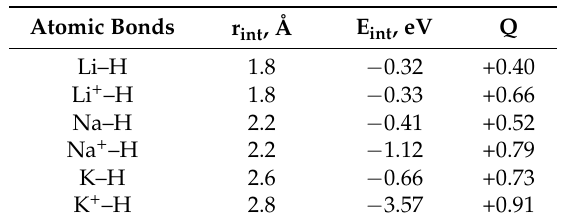
Table 1. The main characteristics of Li, Na, K atom binding to an edge H atom of an amino group that modifies the nanotube surface: r int —interaction distance between a metal atom and H atom of the functional group, E int —a corresponding interaction energy; Q—charges on metal atoms.